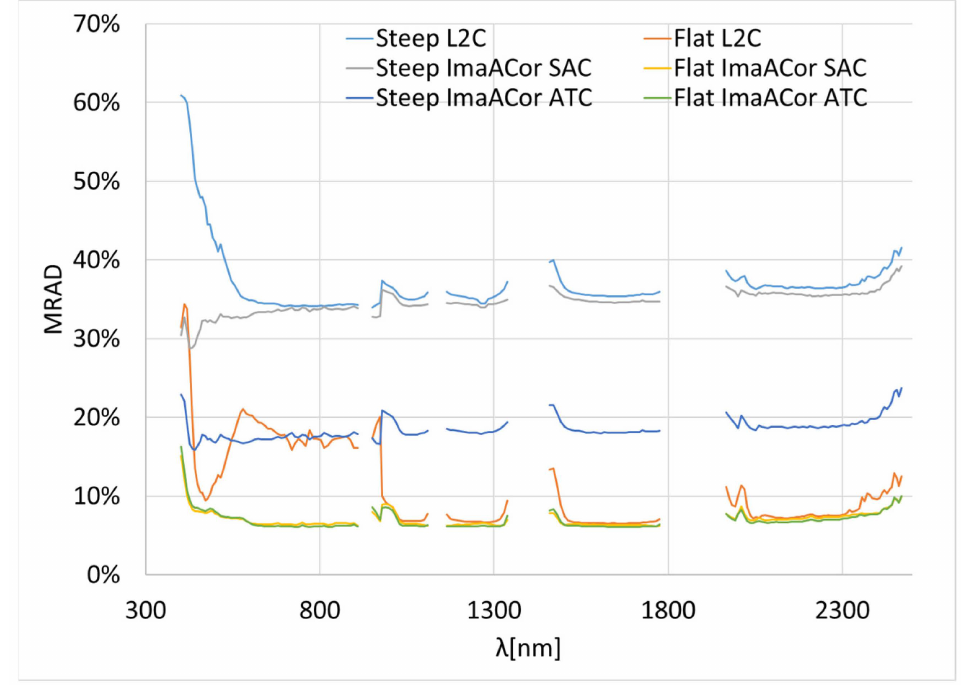
Figure 5. MRAD plots, as a function of wavelength, of the L2C PRISMA reflectances and of the ImaACor SAC and ATC reflectances obtained from the L1 Landsat-8 data, for flat and steep